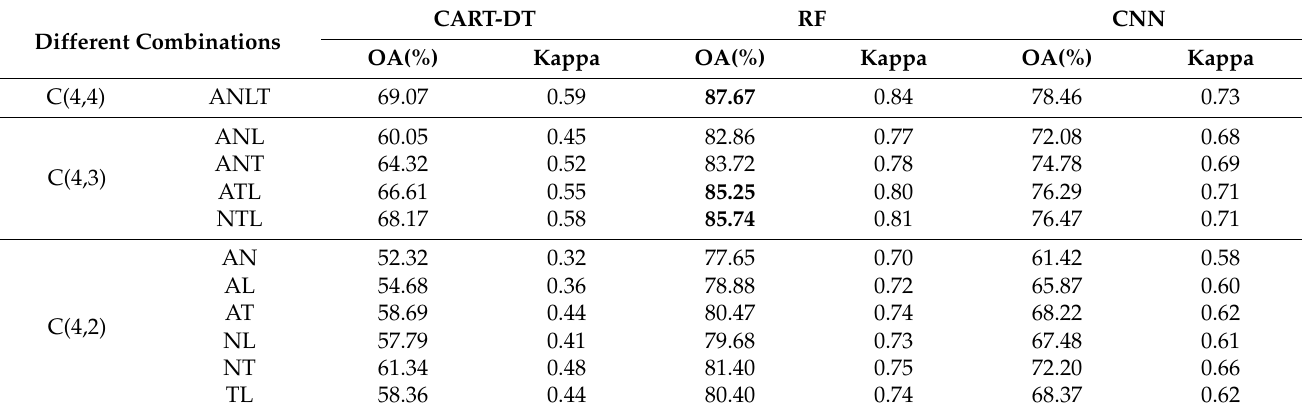
Table 3. The results of model accuracy with different indicator